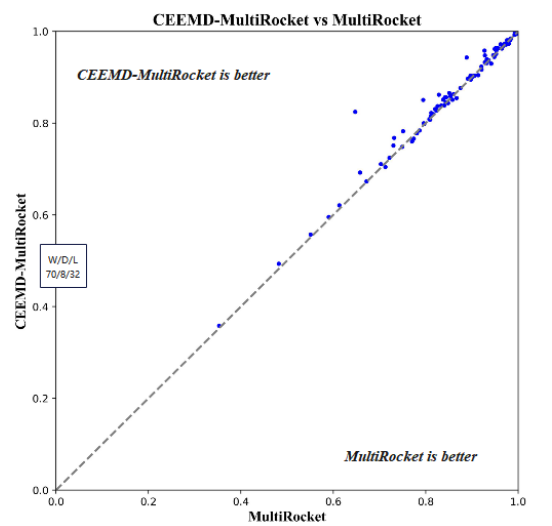
Figure 5. Pairwise accuracy of CEEMD-MultiRocket versus MultiRocket over 30 resamples of 109 datasets from the UCR time series